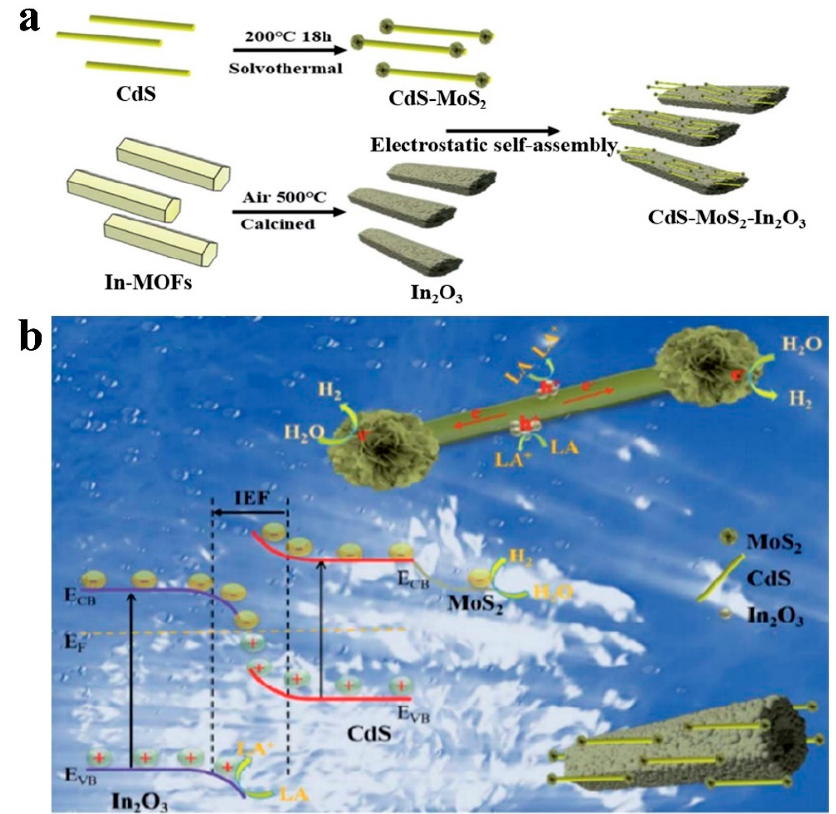
Figure 19. ( a ) The schematic illustration of the synthesis of CdS-MoS 2 -In 2 O 3 . ( b ) A possible hydrogen evolution mechanism of the CdS-MoS 2 -In 2 O 3 ternary nanocomposite photocatalyst. Reproduced with permission from Ref. [87].